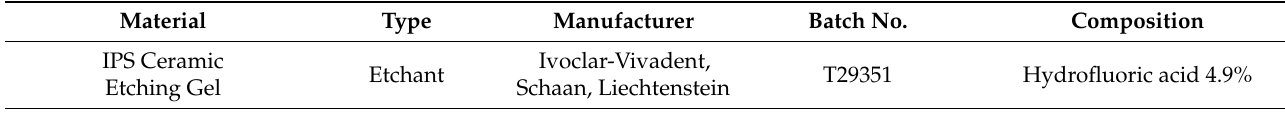
Table 1. Materials used in the study (information as disclosed by the